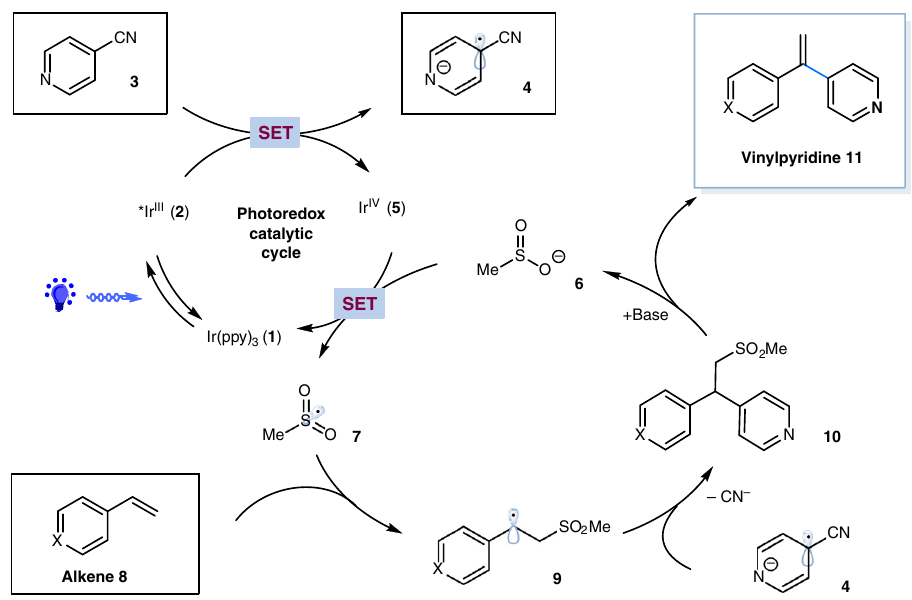
Fig. 2 Proposed mechanism. Possible reaction pathway utilizing sul fi nate as a promoter